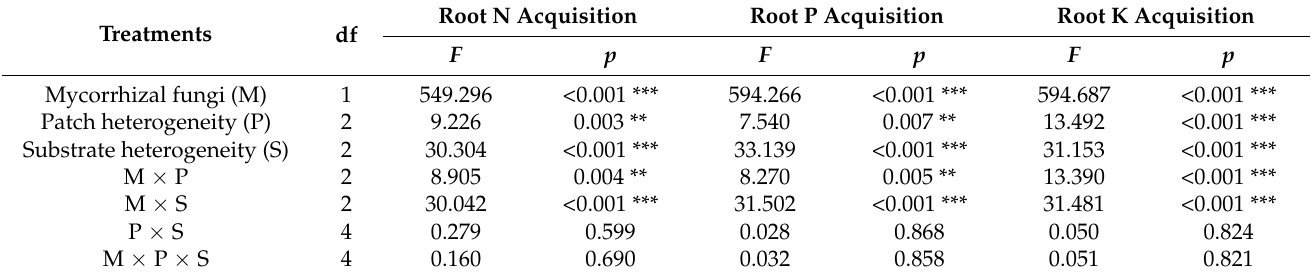
Table 6. Three-way ANOVA for the effect of mycorrhizal fungus (M + vs. M − ), patch heterogeneity (Homo vs. Hetl vs. Hets), and soil substrate heterogeneity (GL vs. GF vs. GH) on the N and P acquisitions.